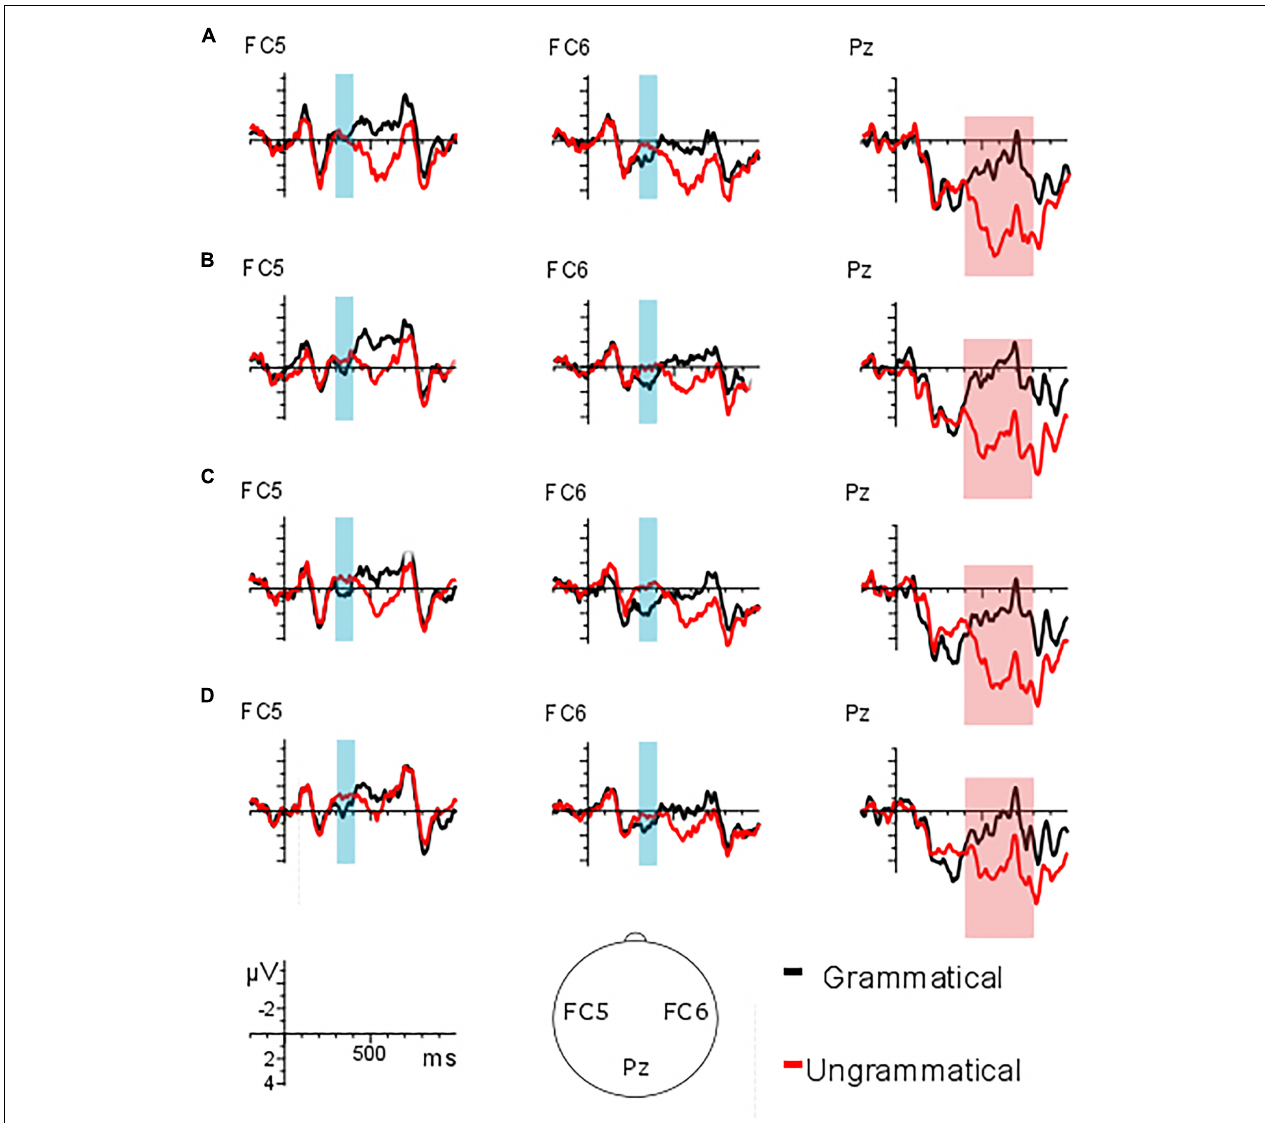
FIGURE 3 | (A) Person feature unaccusative predicate condition; (B) number feature unaccusative predicate condition; (C) person feature unergative predicate condition; (D) number feature unergative predicate